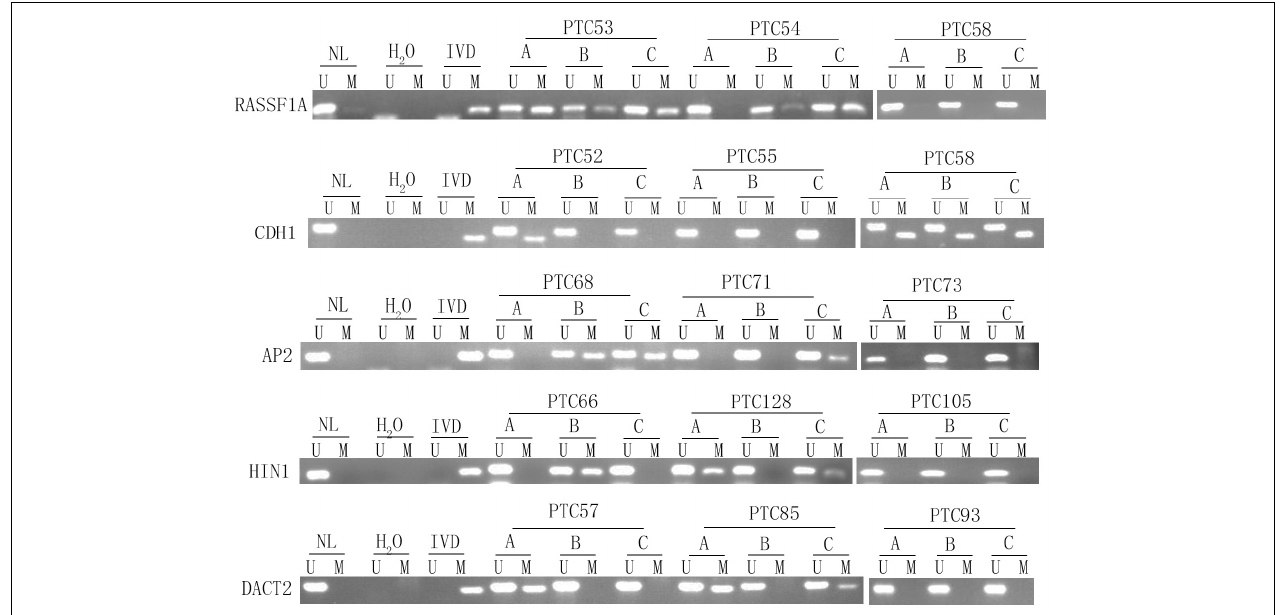
FIGURE 3 | Representative methylation heterogeneity results for each of five genes. IVD, in vitro -methylated DNA (methylation control); NL, normal lymphocyte DNA (unmethylation control); H 2 O, double distilled water; U, unmethylation; M, methylation; PTC, papillary thyroid